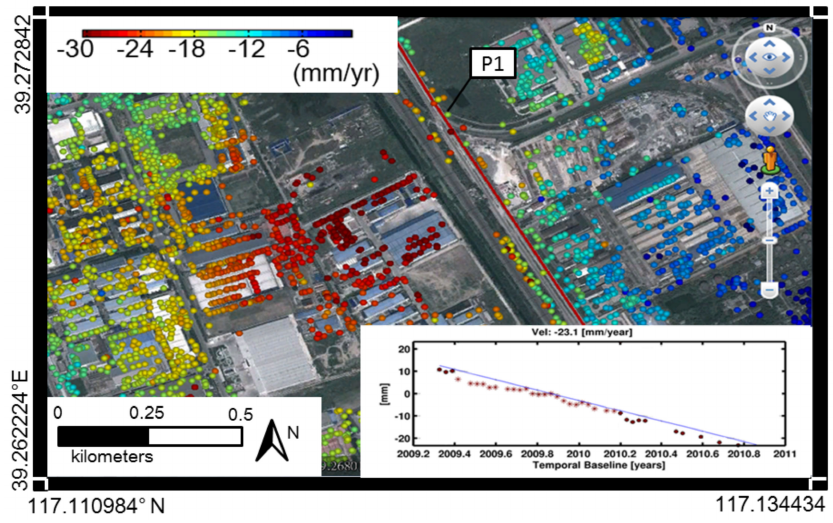
Figure 4. A set of PSs geocoded in Google Earth, and a section of Jingjin Inter-City Railway near Shuangjie Town. The red line highlights the railway. P1 gives the location of the selected PS point, and its deformation history is displayed in the lower right corner. The deformation velocity is presented along the LOS